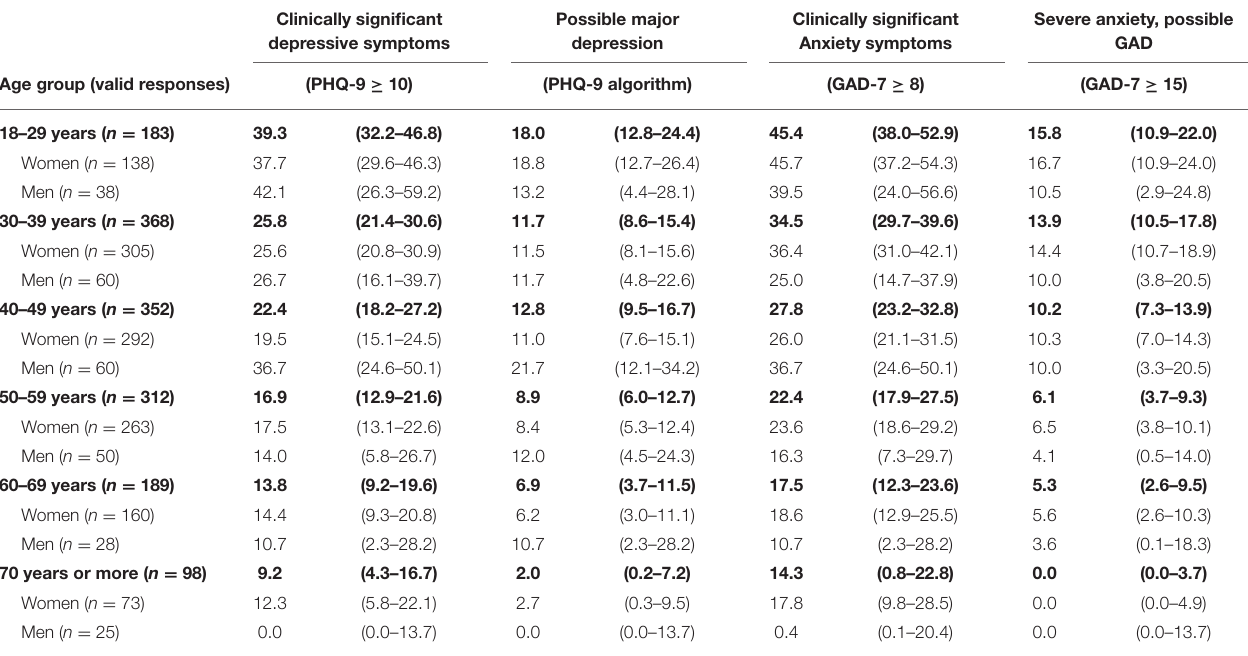
TABLE 4 | Prevalence (%) of depression and anxiety in different age groups ( n =